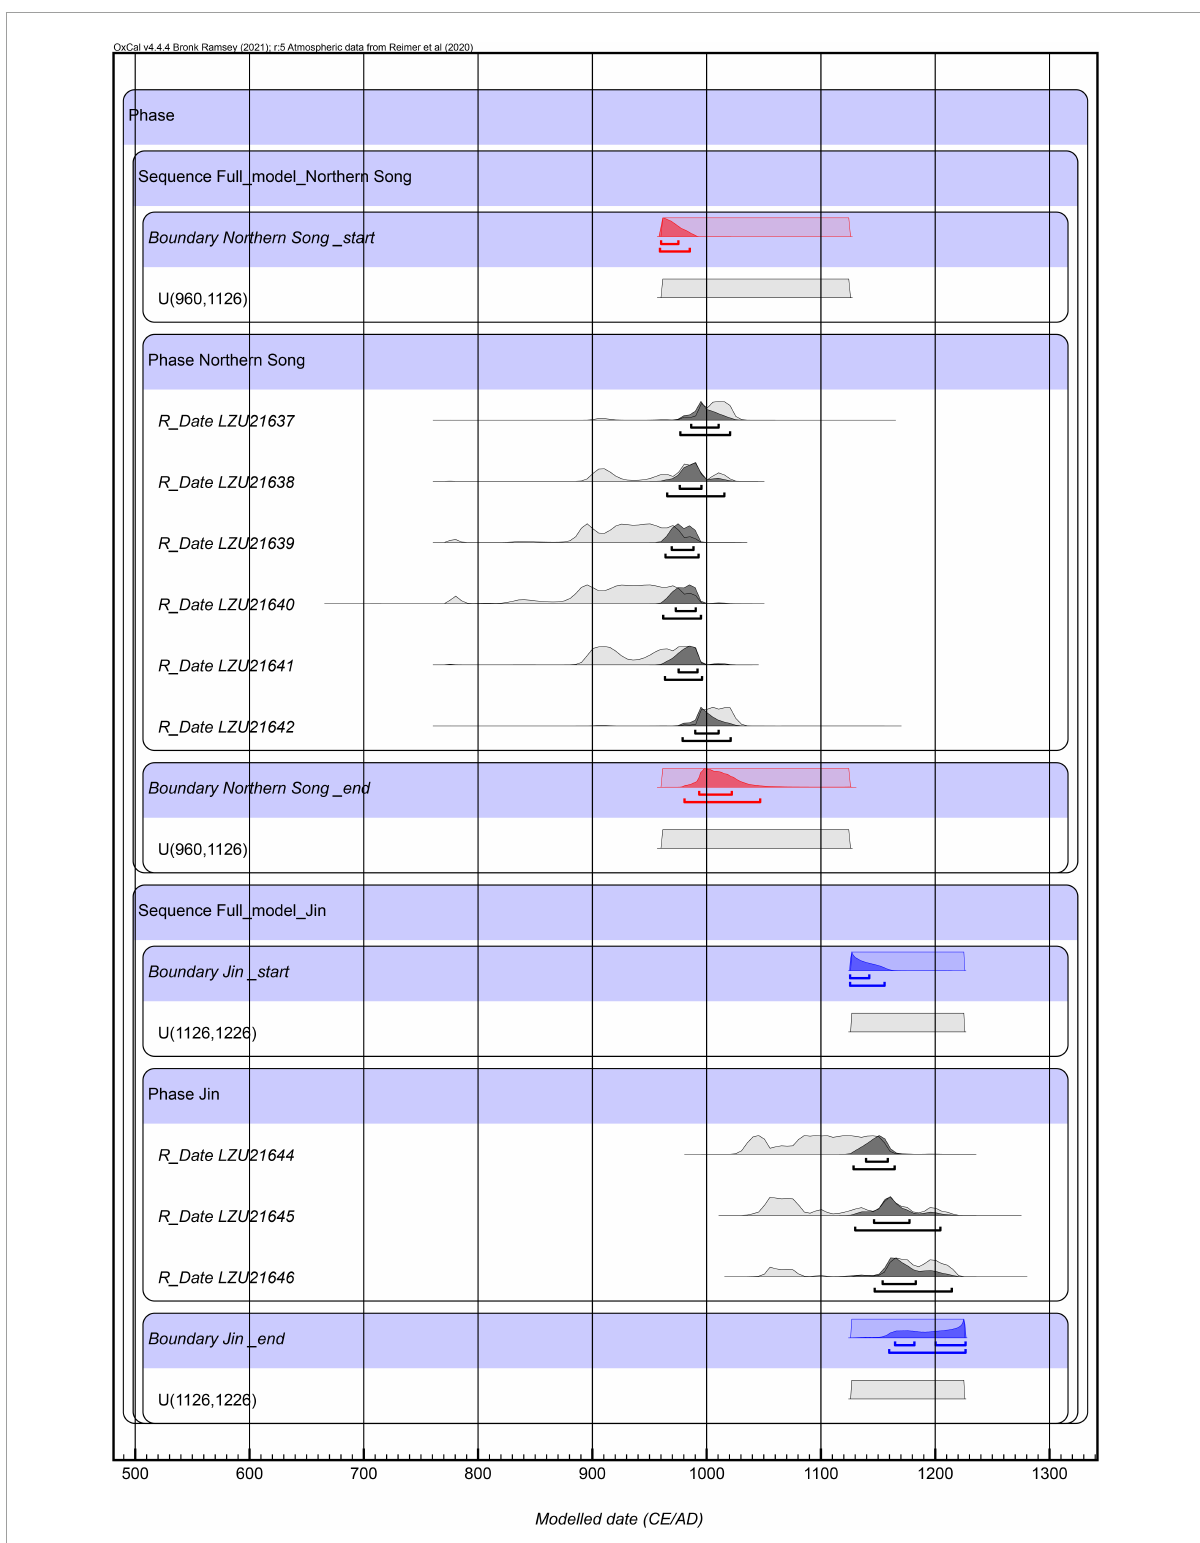
FIGURE3 Radiocarbon dates from ZKS site, 2020 excavation calibrated in a Bayesian model incorporating stratigraphy and phasing, using OxCal 4.4 software.